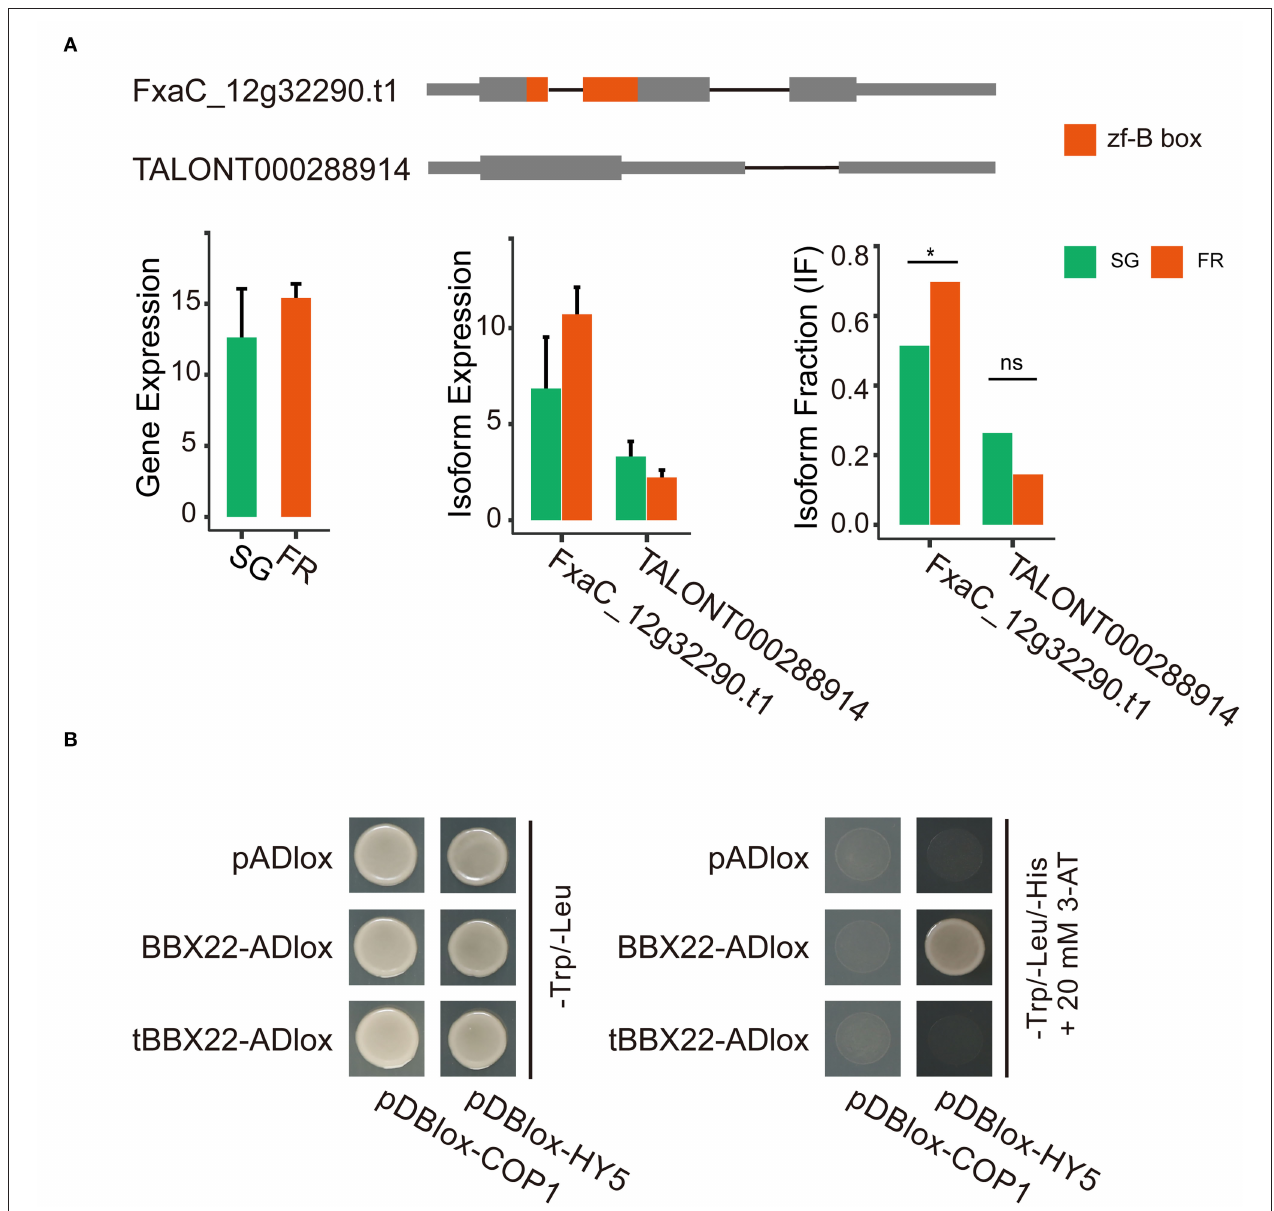
FIGURE 6 | Isoform switching of the two representative isoforms of the strawberry BBX22 gene and their functional divergence revealed by yeast two-hybrid assays. (A) Gene models of each isoform and the abundance of the gene or the expression of each isoform in the small green and full red stage fruits. The zf-B box domain coding region is in red. Significant isoform switching events detected by DEXseq ( p adj < 0.05) implemented in the IsoformSwitchAnalyzeR package were labeled with a star (*) symbol. (B) Yeast two-hybrid screening for interactions between the HY5/COP1 and the BBX22 or the truncated BBX22 protein